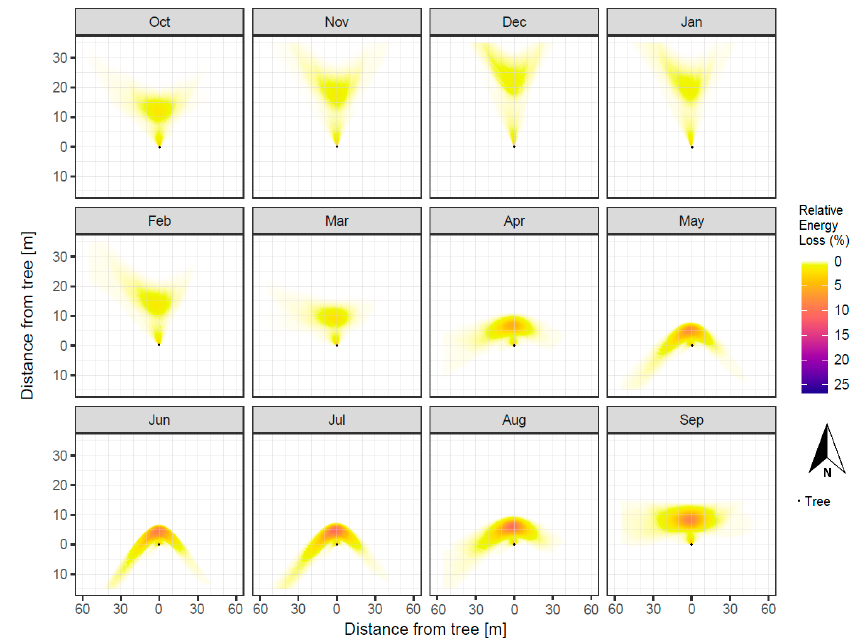
Figure 4. Monthly grids of solar energy losses from October 2013 until September 2014 in comparison to unshaded areas.